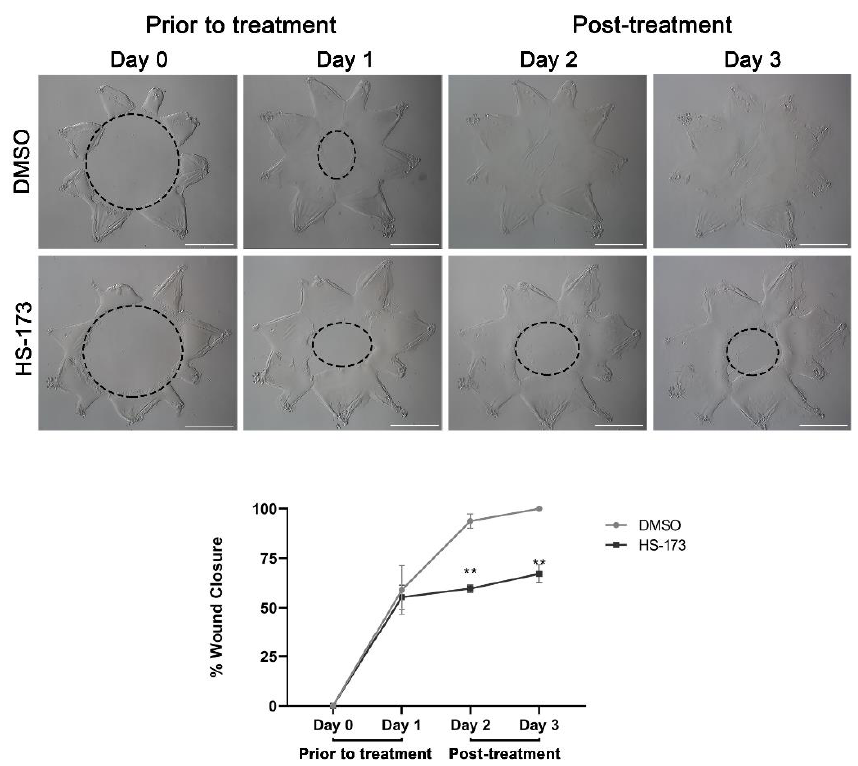
Figure 4. p110 α is required throughout the wound healing process to sustain wound closure. Ex vivo post-cataract surgery explants were treated with HS-173 to inhibit p110 α from Day 1 to Day 3 post- injury. Phase microscopy and wound area measurements show the wound area prior to treatment on Day 0 and Day 1 and post-treatment with vehicle or HS-173 on Day 2 and Day 3 (dotted black circle). Graph depicts % wound closure and revealed that HS-173 is required throughout the wound healing process to drive wound closure. p -values were determined from two-way ANOVA with multiple comparisons (** p < 0.01). Data is expressed as ± SEM from 3 independent experiments. Magnification bars = 1000 μ m .